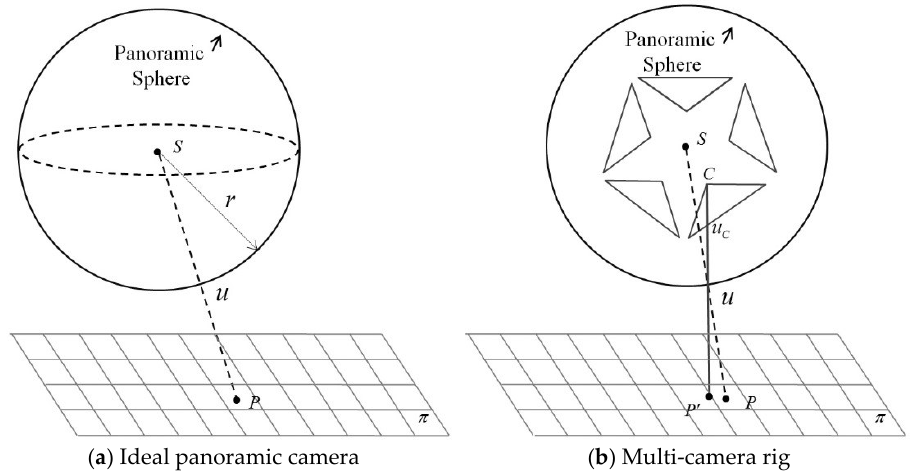
Figure 2. The ideal panoramic camera ( a ) where S , u , and p are collinear, and the multi-camera rig ( b ) where in fact C , u , and p ′ are collinear and C and S don’t overlap.